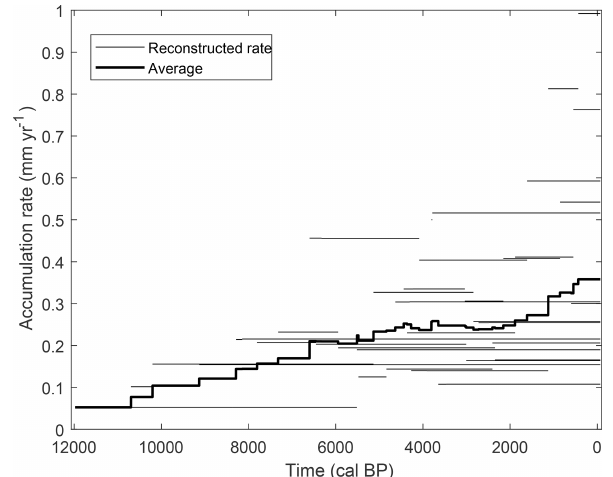
Figure 15. Reconstructed peat accumulation rates based on all available radiocarbon dates within the study area and the mean peat accumulation